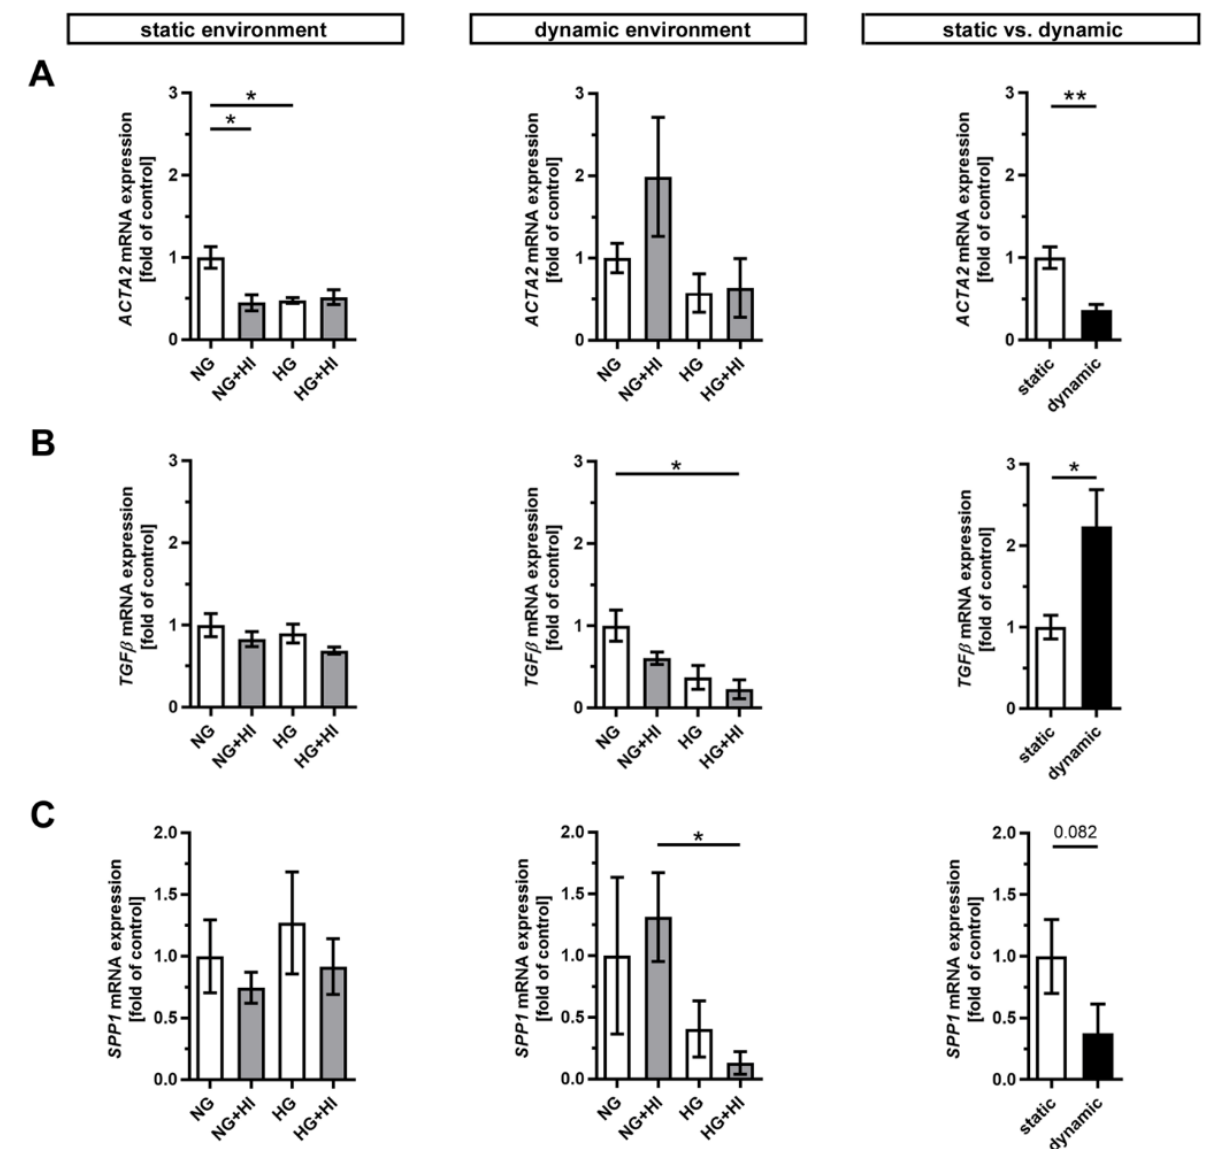
Figure 2. Gene expression of key differentiation markers in AV tissue. ( A – C ) Treatment with chronic HI or HG as well as the combination of those led in static cultivated AV leaflets to a decreased gene expression of α smooth muscle actin ( ACTA2 ). Samples under dynamic condition of the bioreactor system in turn react with the downregulation of transforming growth factor β ( TGF β ) and osteopontin ( SPP1 ) under experimental diabetic conditions. Direct comparison of basal NG conditions showed a significant reduction in ACTA2 and an increase in TGF β gene expression under dynamic flow conditions compared to statically cultivated AV tissue, whereas SPP1 gene expression remained unchanged. n = 5–6; *: p < 0.05; **: p < 0.01; NG: normoglycemia; HI: hyperinsulinemia; HG: hyperglycemia.